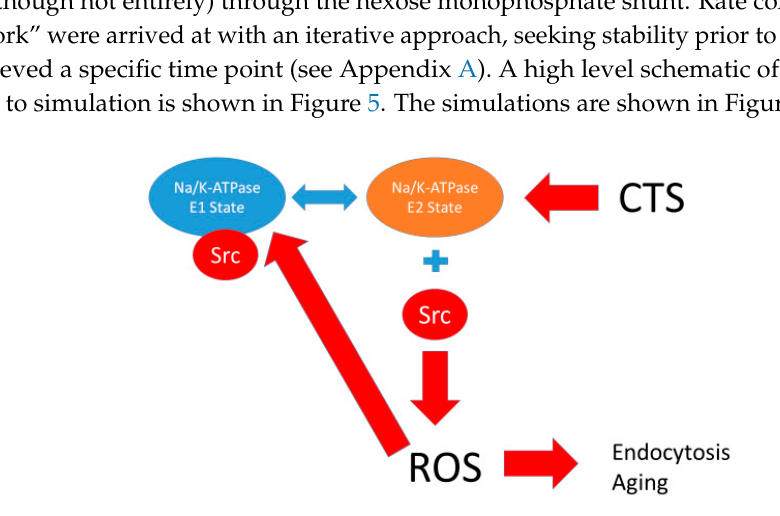
Figure 5. Schematic of Na/K-ATPase showing the release of Src with conversion into the E2 state (stimulated by ROS and CTS) with further generation of ROS inducing endocytosis and aging. See associated differential equations in Appendix A.